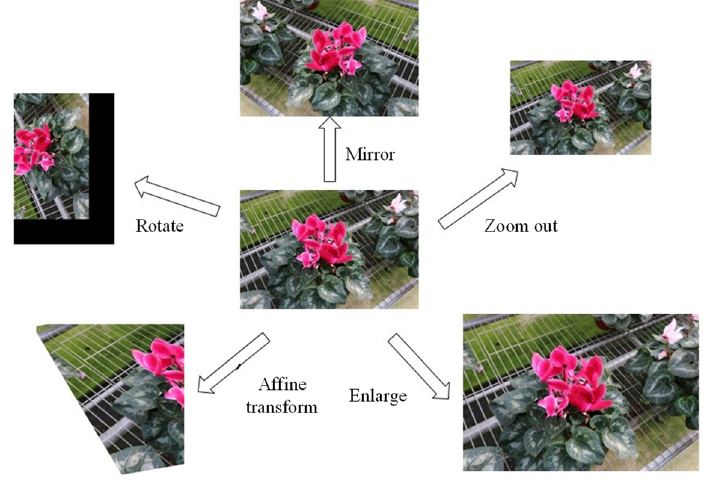
Figure 3. Data augmentation after mirroring, shrinking, enlargement, rotation, and affine transformation.